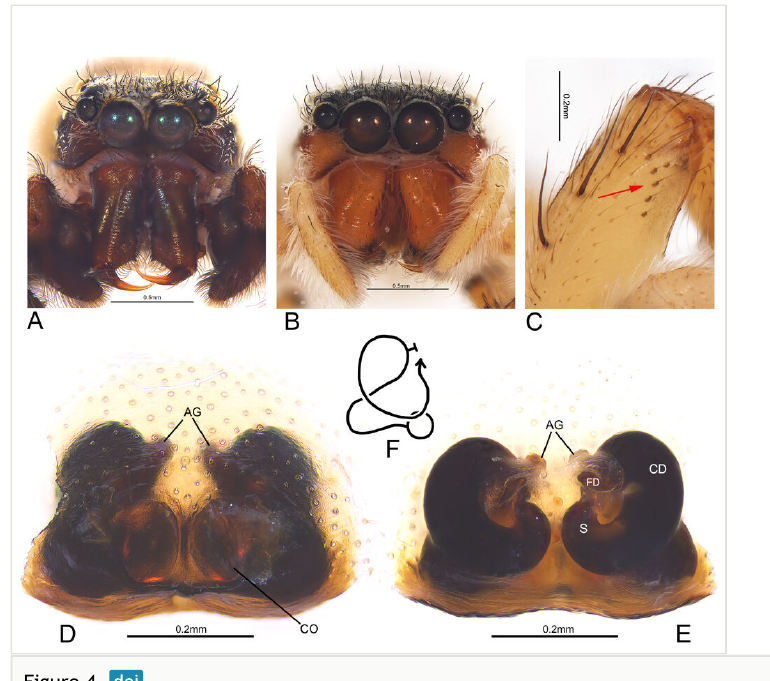
Figure 4. Tasa koreanus (Weso ł owska, 1981): A male cephalothorax, frontal view; B female cephalothorax, frontal view; C female left femur I, prolateral view, red arrow points to the sclerotic and raised sockets; D epigyne, ventral view; E vulva, dorsal view; F schematic of internal duct system, dorsal view. Abbreviations: AG—accessory gland; CD—copulatory duct; CO—copulatory opening; FD—fertilisation duct; Carapace dark brown, elongate and flat, nearly rectangular; dorsal surface covered with dense white hairs (Fig. 2A); lateral surface hairless (Fig. 1B). Fovea indistinct, short and longitudinal. Eye field black, surrounded by sparse black setae. Chelicerae dark brown (Fig. 4A), with two promarginal and one retromarginal teeth. Labium black and as wide as long. Endites dark brown. Sternum brown. Abdomen elongated oval, grey-white, covered with dense white hairs and sparse black hairs, with a pair of light brown, mottled stripes running through entire dorsum; dorsal scutum absent (Fig. 2A); venter with two columns of indistinct sclerites between epigastric furrow and spinnerets; spinnerets brown (Fig. 2B). Leg I dark brown; legs II–IV yellowish-brown (Fig. 2B). Palps dark brown. Spination of legs as shown in Table 1. Palp (Fig. 3A–E). Bulb nearly triangular in ventral view, retrolateral side with a small protrusion; sperm duct extending along margin; tegular lobe curved prolaterally. Embolus stubby and hook-shaped. RTA bifurcated, ventral branch as long as dorsal branch, blunt; dorsal ramus well-developed, pointed with about ten teeth of various sizes, along ventral margin, distributed from RTA base to tip of dorsal branch. Cymbium distally curled retrolaterally, forming a groove to accommodate embolus.